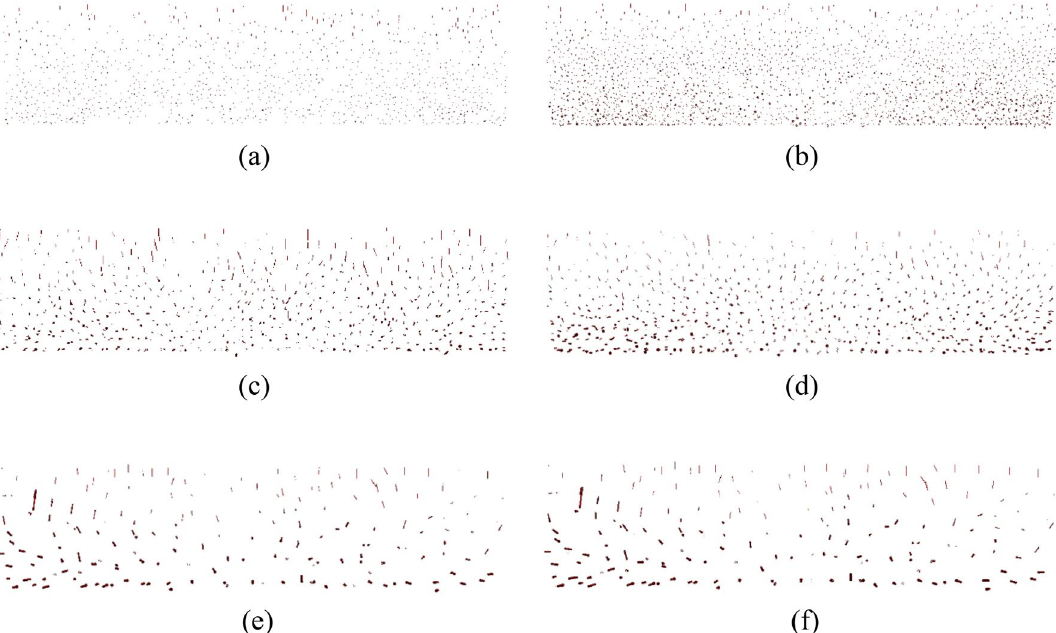
Figure 8. Incremental displacement vectors for global shear strain interval (Side view): ( a ) 1D 20% shear strain, ( b ) 1D 40% shear strain, ( c ) 2D 20% shear strain, ( d ) 2D 40% shear strain, ( e ) 4D 20% shear strain, ( f ) 4D 40% shear strain.